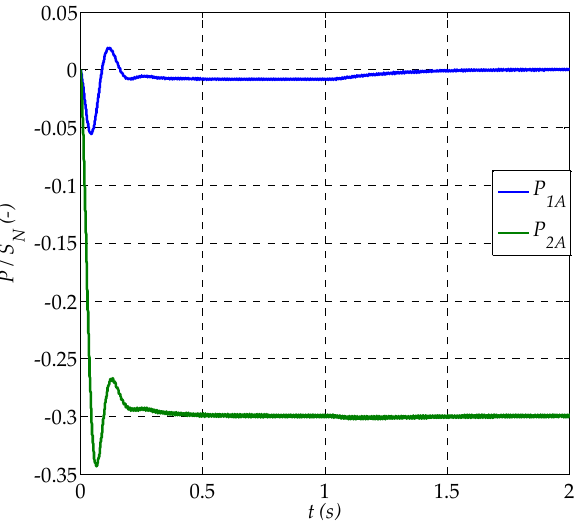
Figure 6. Waveforms of active powers P 1A and P 2A for RL load, p.f. = 0.8.